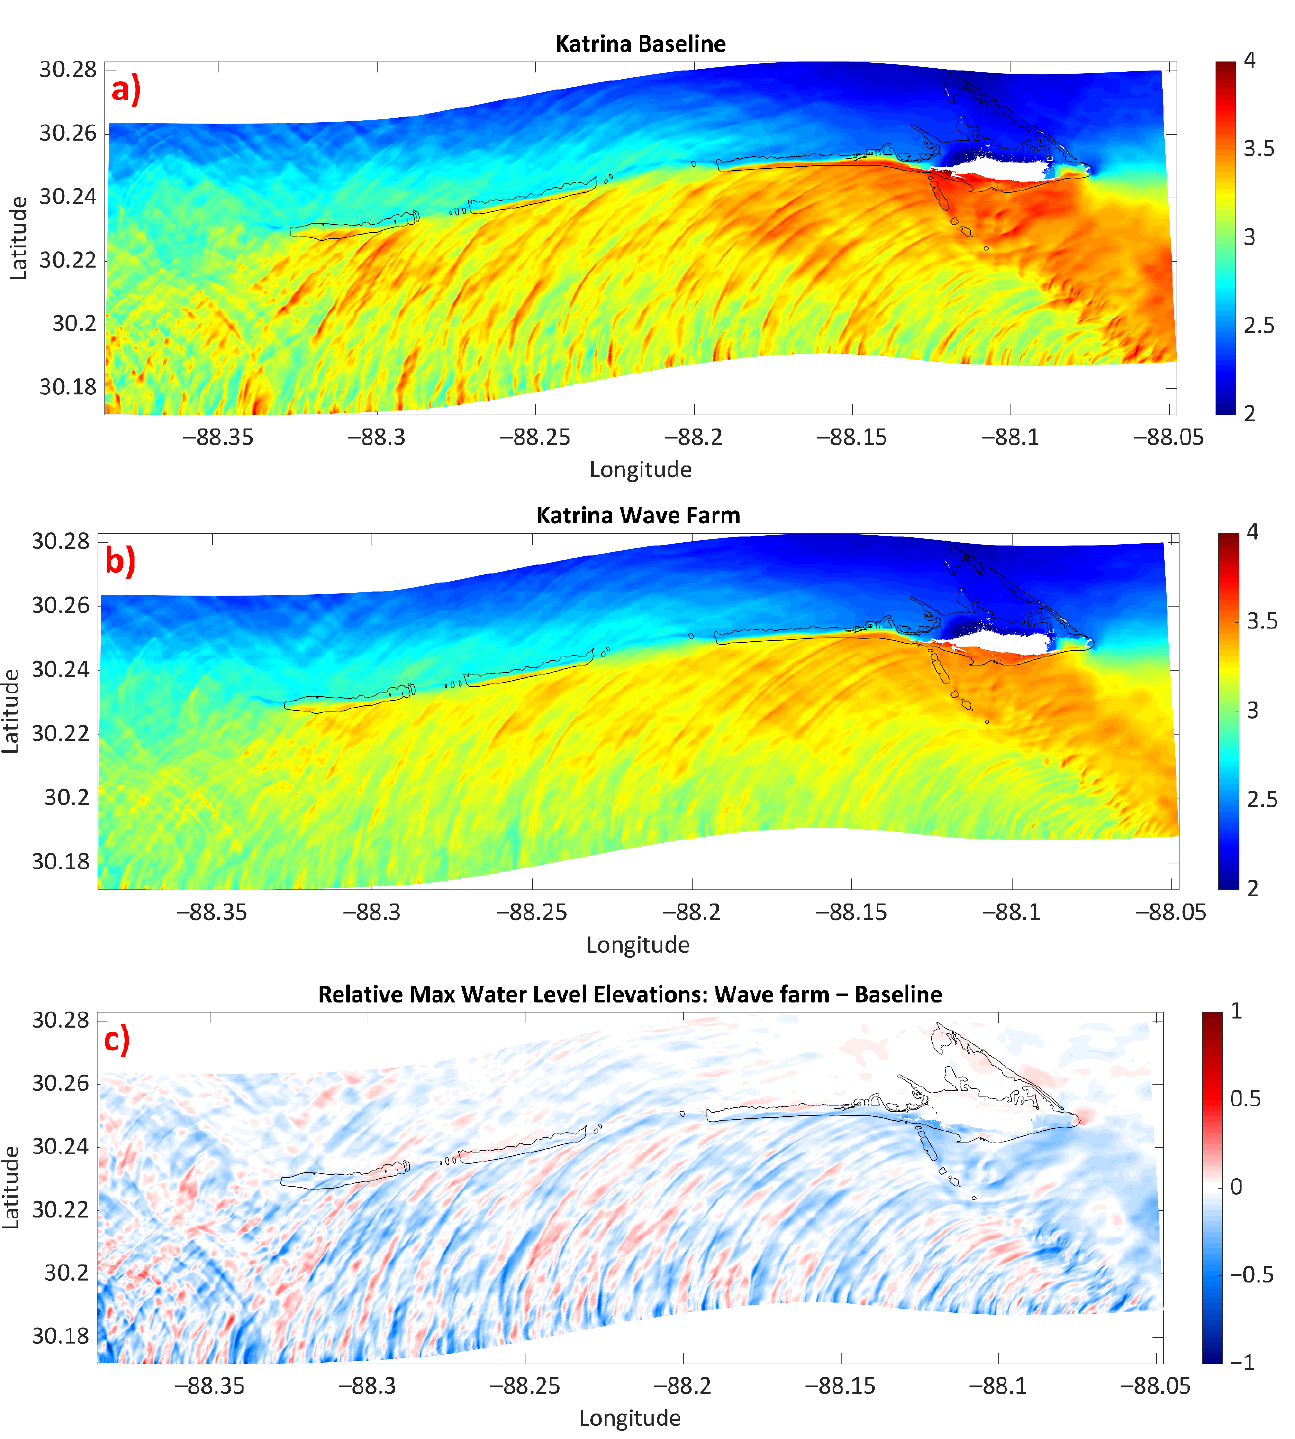
Figure 10. Hurricane Katrina bed levels (BL) and water levels (WL) at the west ( a ), middle ( b ), and east ( c ) transects on Dauphin Island, AL under baseline and wave farm scenarios. Note that the figures are zoomed in for readability. Initial WL is at the zero level for all transects. Black dashed line shows the 0 m elevation.